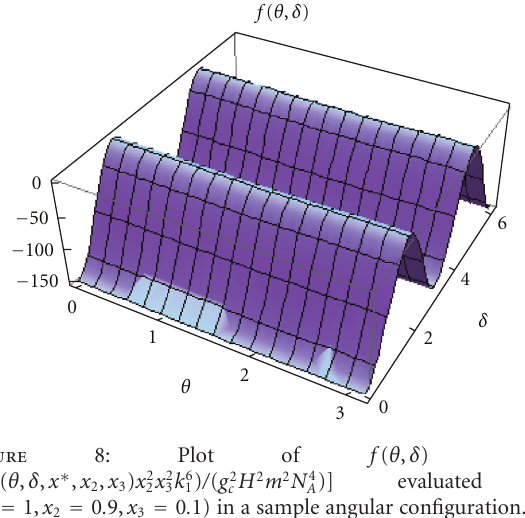
)] evaluated at H 2 m 2 N 4 A c